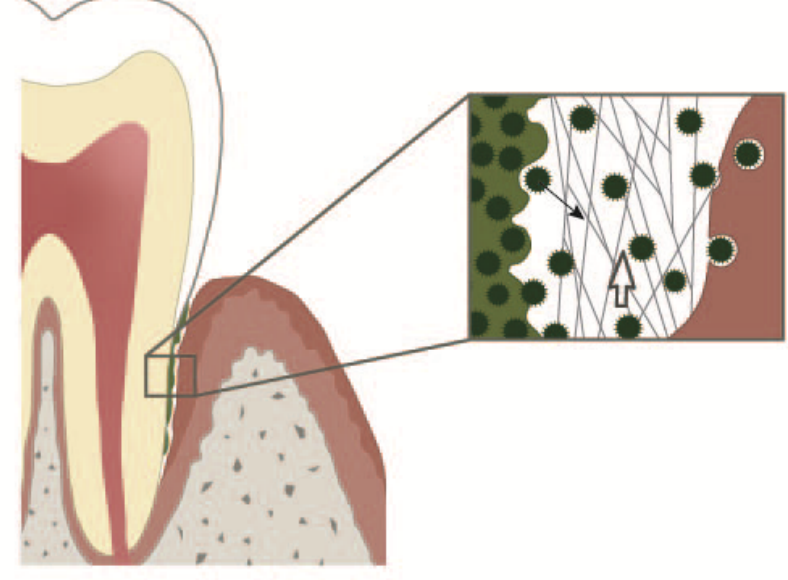
Figure 1. Periodontal crevice. On the left: subgingival plaque. On the right: an epithelial cell with an adherent bacterium and bacteria in different stages of internalisation. In the middle: periodontal crevice. Neutrophil extracellular trap (NETs) build a 3D web work protecting the gingiva from bacteria dispersing out of the subgingival plaque. NETs together with the entrapped bacteria are continuously pushed into the oral cavity by the crevicular exudate outflow. Open white arrow: direction of the crevicular exudate outflow. Solid black arrow: a bacterium dispersing from the subgingival plaque.